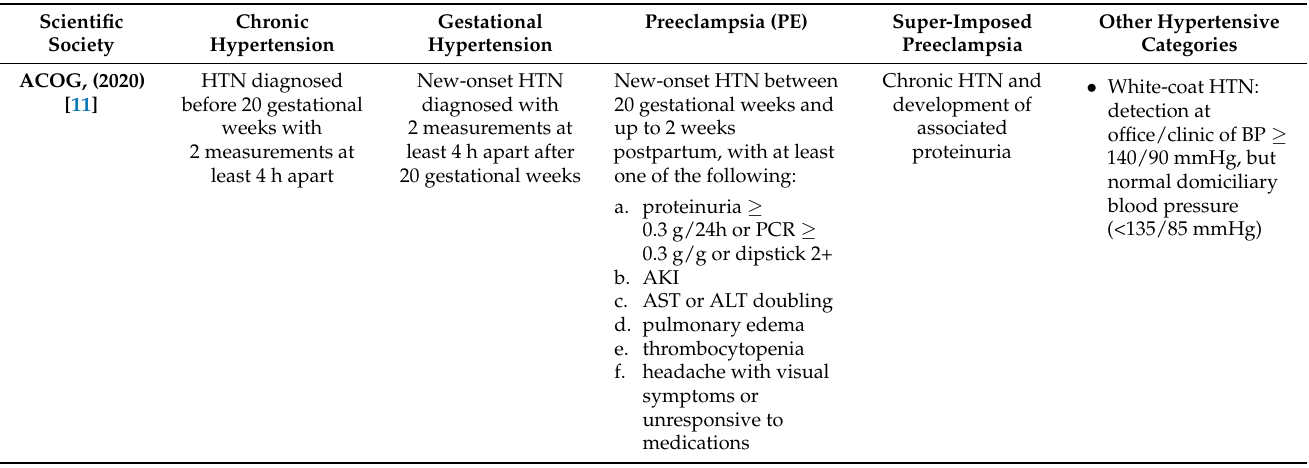
Table 1. Definitions of the hypertensive disorders of pregnancy, as found in the national and international